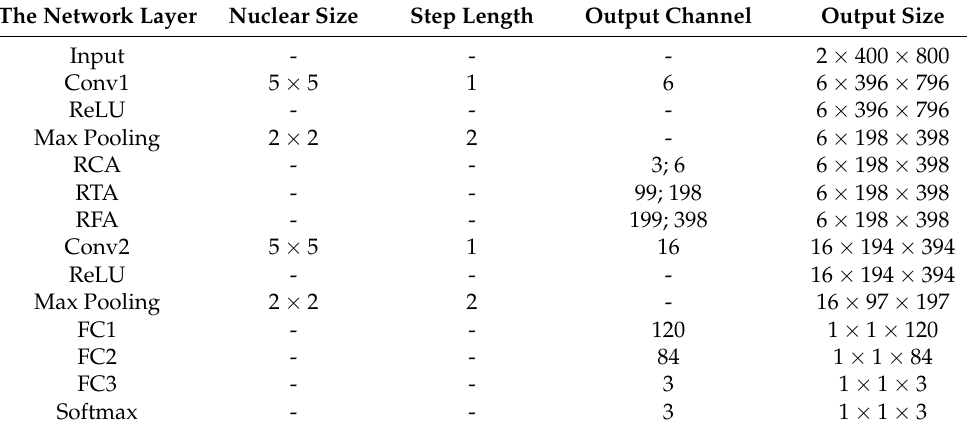
Table 2. RTFANet model parameter